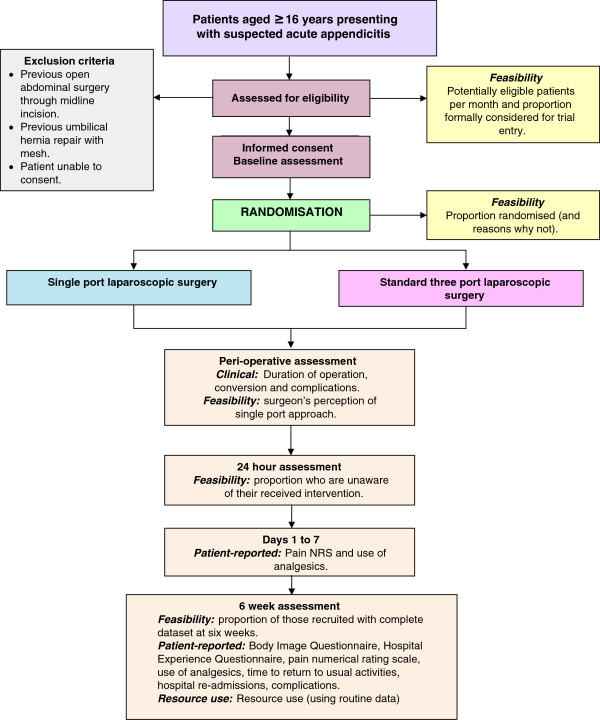
Trial flow diagram.